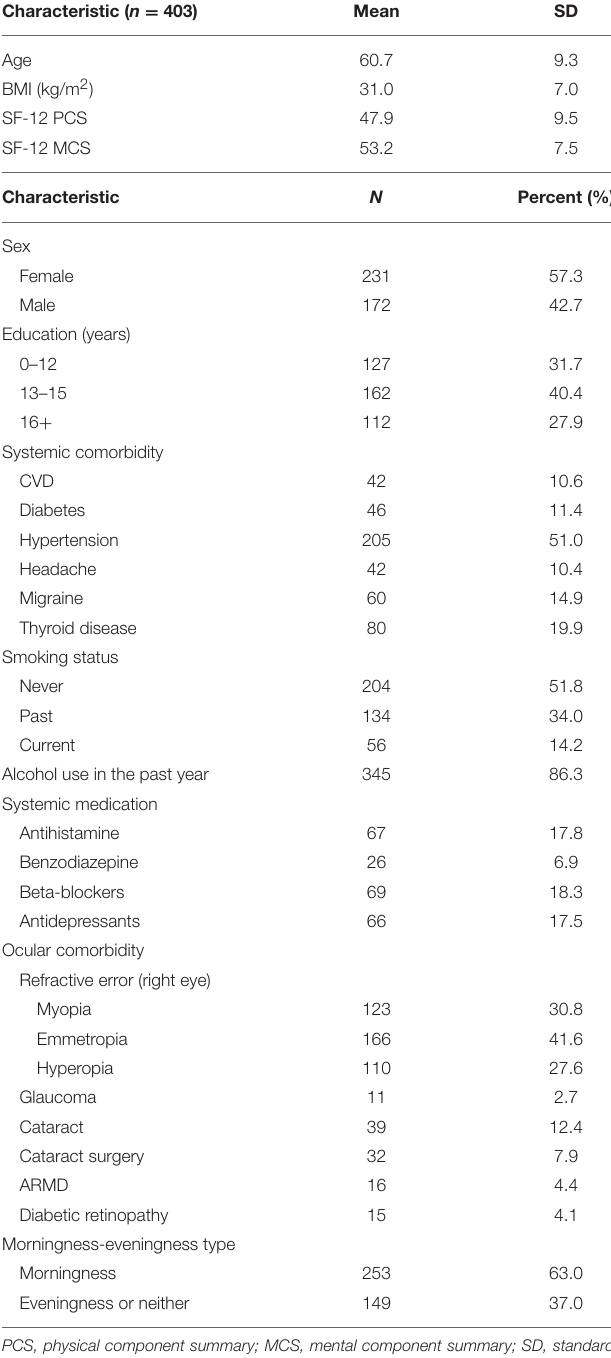
TABLE 1 | Participant characteristics. TABLE 2 | The full model with the adjustment for variables to assess the